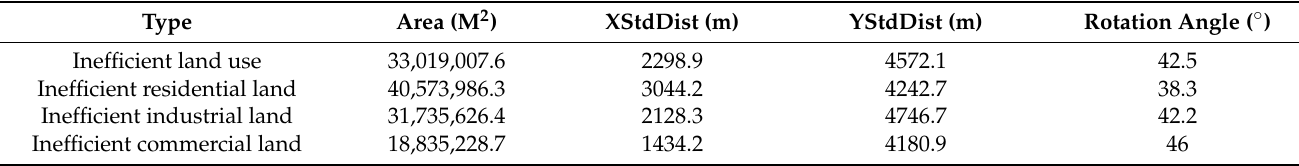
Table 8. Standard deviation ellipse parameters of urban inefficient land use location